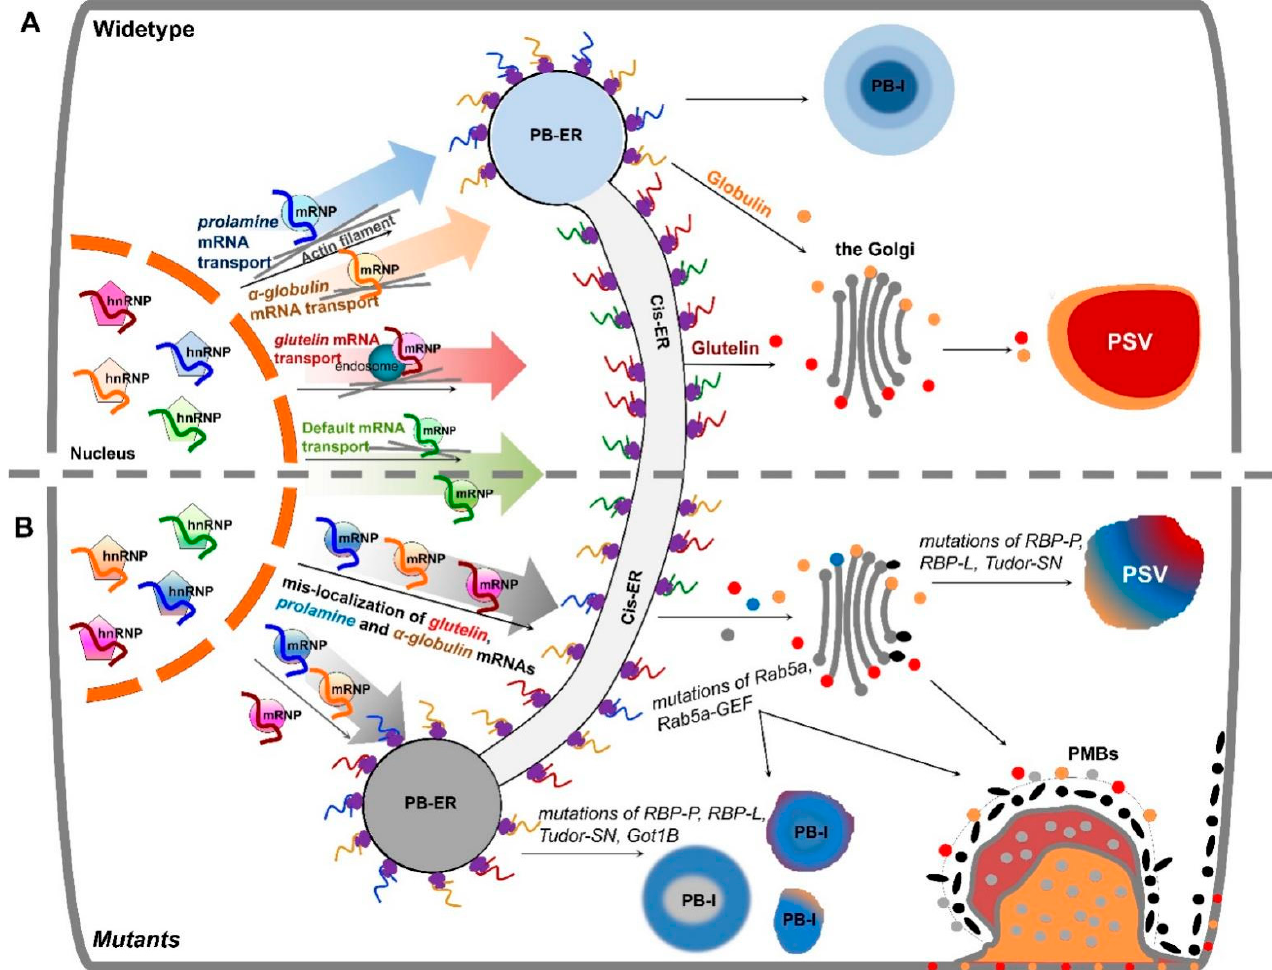
Figure 1. Schematic model of mRNA transport to the cortical ER in developing rice endosperm cells. ( A ) Working model of three pathways to transport mRNAs to distinct ER subdomains in wildtype. The localization of storage protein mRNAs initiates in the nucleus, where newly transcribed mRNAs are recognized and bound by various sets of specific RBPs, forming heterogenous nuclear ribonucleoprotein (hnRNP) complexes. After export from the nucleus to cytoplasm, the complexes undergo dynamic remodeling to form mRNPs that recruit molecular motor proteins for actively transporting to distinct ER subdomains likely on actin filaments (grey lines). Glutelin mRNAs (red curve line) are targeted to the cis-ER via endosomal trafficking. Following translation, proglutelins are transported via the Golgi complex to the irregularly shaped PSV, where they are proteolytically processed to acidic and basic subunits and accumulated in the crystalline regions of the PSV (shown in red). Prolamine (blue curve line) and α -globulin (orange curve line) mRNAs are transported to the PB-ER, where the mRNAs are translated and newly synthesized prolamine polypeptides are assembled as an intracisternal granule to form multi-layered PB-I. The synthesized α -globulins